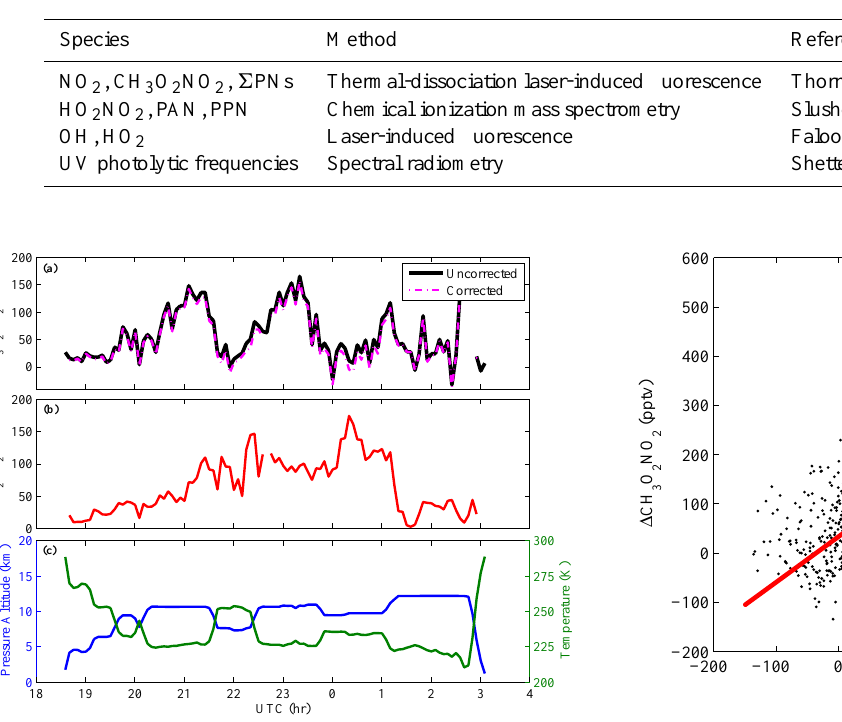
Figure 7. Five-minute-averaged time series of (a) uncorrected (black) and corrected (magenta) CH 3 O 2 NO 2 for HO 2 NO 2 thermal decomposition, (b) HO 2 NO 2 , and (c) pressure altitude (blue) and temperature (green) from a flight on 30 May 2012 during DC-3. Local sunset is approximately 00:00UTC.